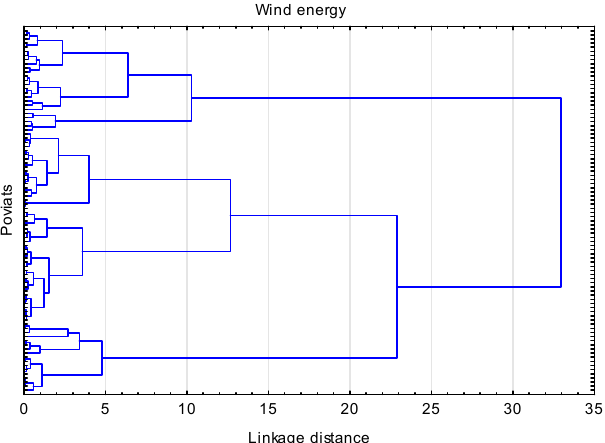
Figure A2. Dendrogram for poviats agglomeration, Ward linkage method with Euclidean distance–wind energy.